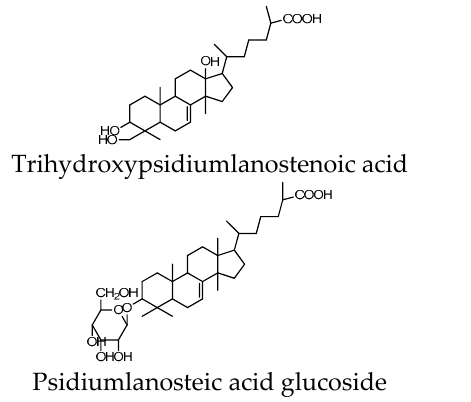
Figure 4. Lanosterol derivates as α -glucosidase inhibitor [35].